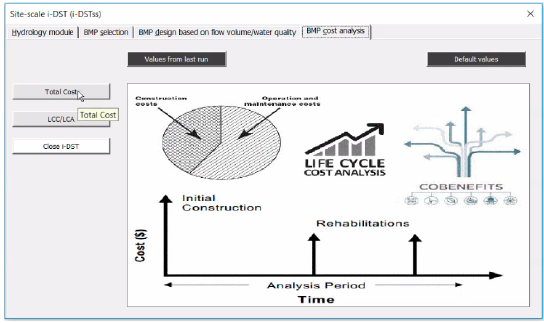
Figure A20. Cost Module